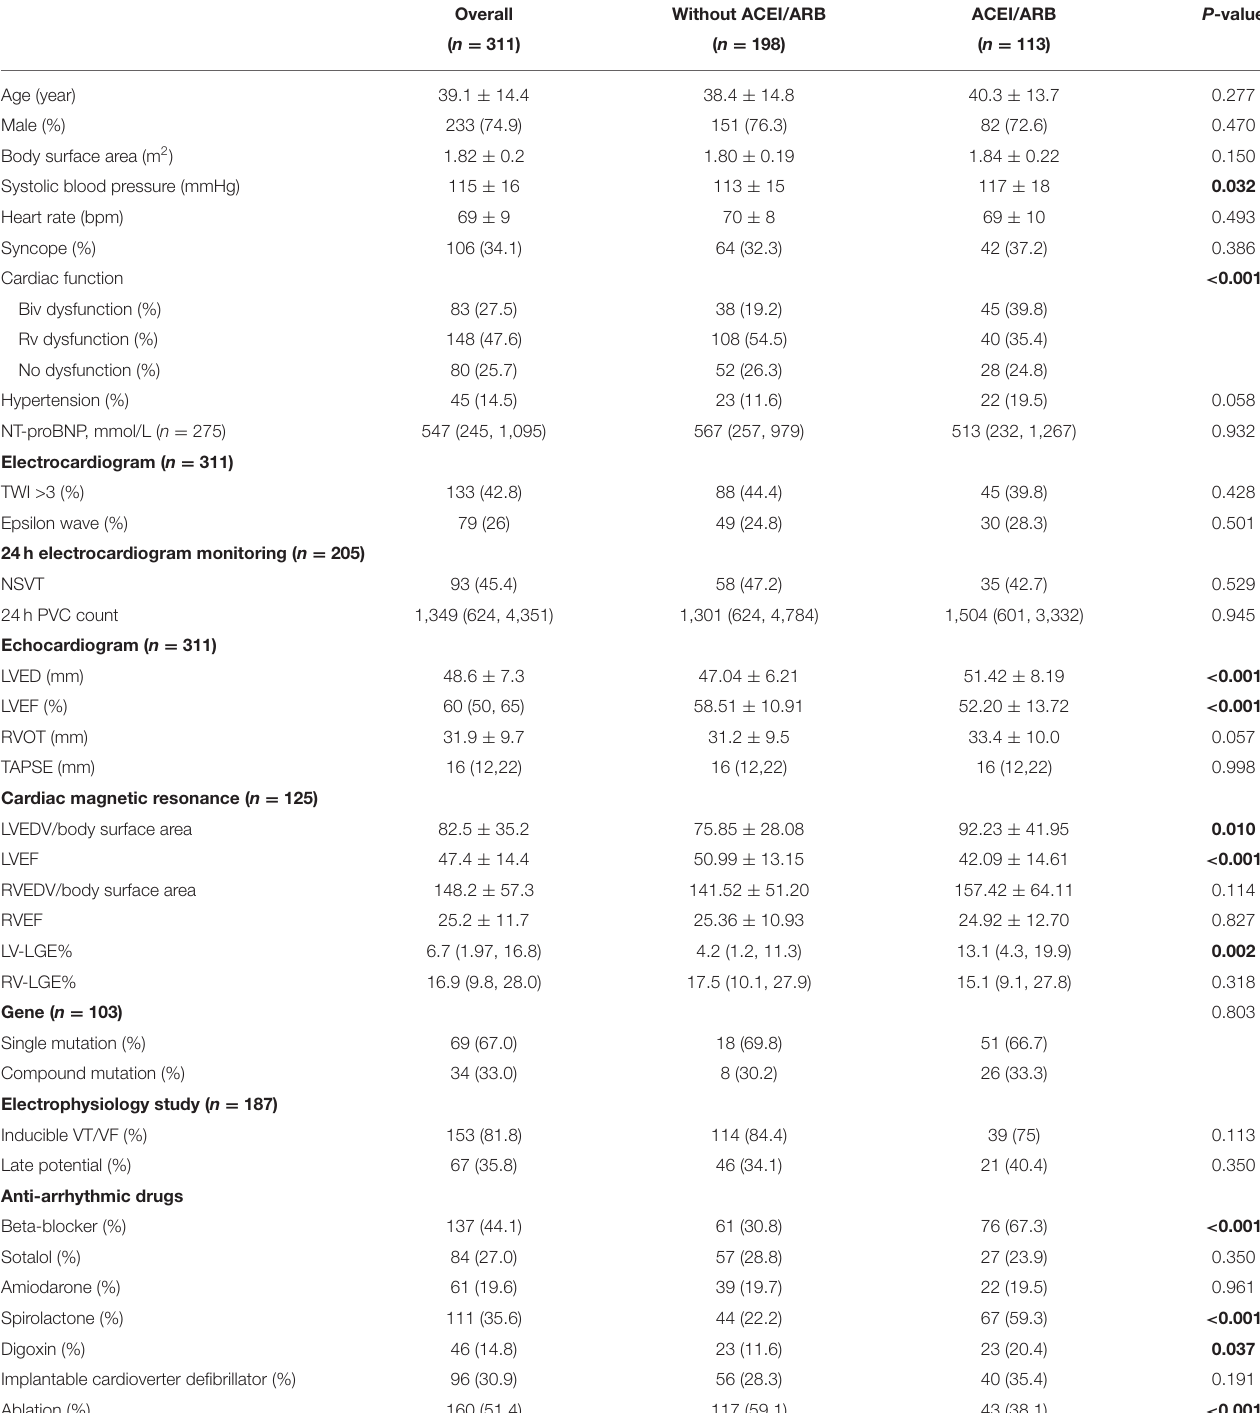
TABLE 1 | Baseline clinical